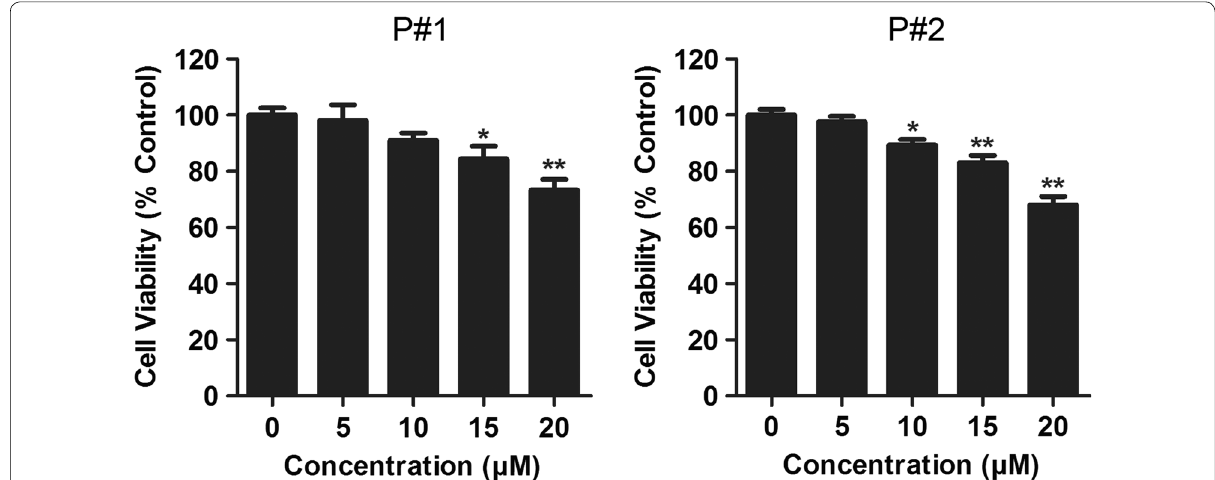
Fig. 1 PARP inhibition reduced the cell viability of primary CML cells. CML P#1 and P#2 cells were incubated with indicated concentration of PARP inhibitor talazoparib for 48 h. Cell viability was detected by CCK-8 assay. ( N